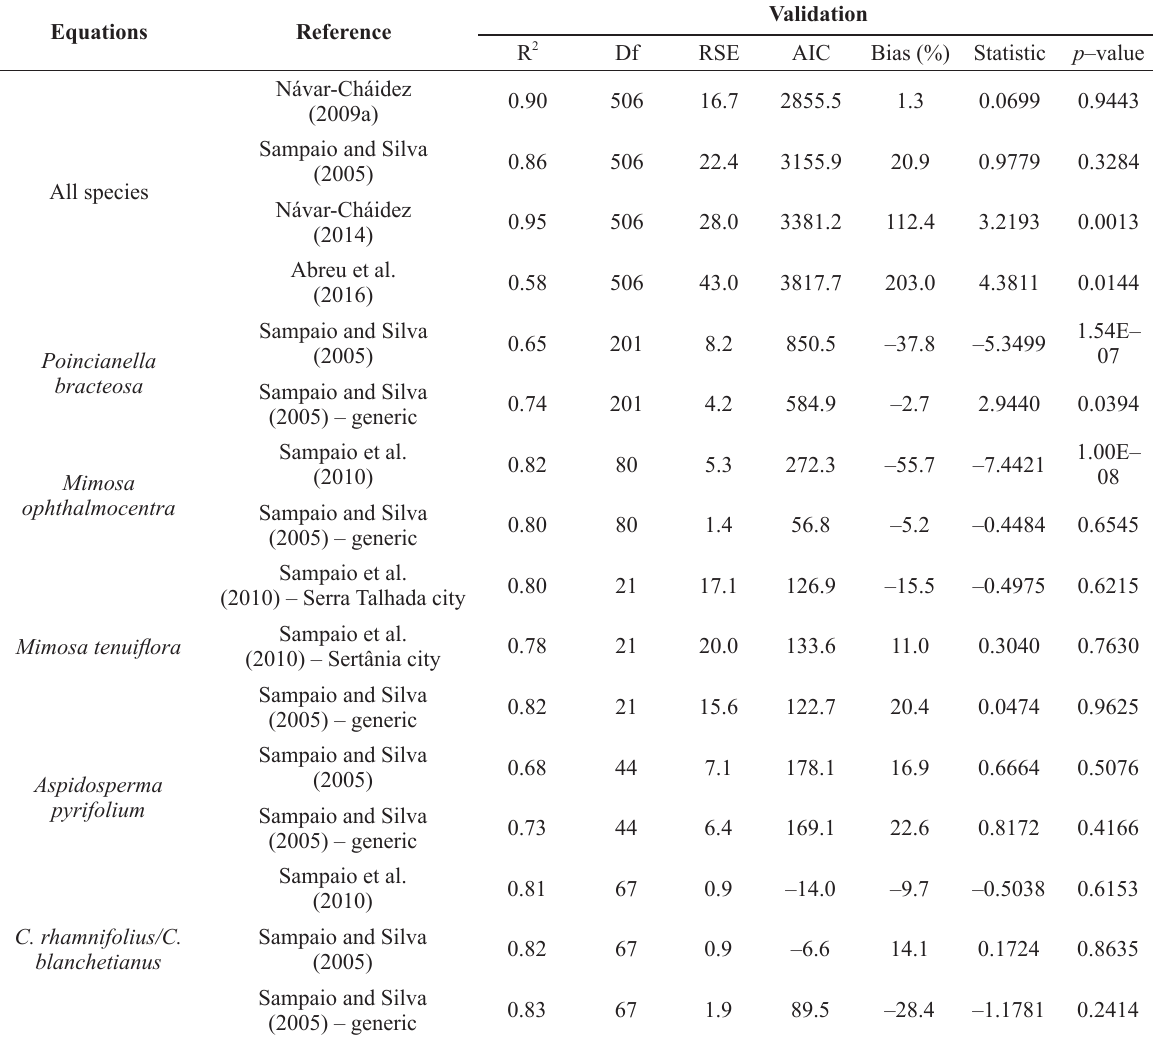
Errors, trends, qualities and paired t-test for aboveground biomass estimates of validated equations for multi-species and individual species